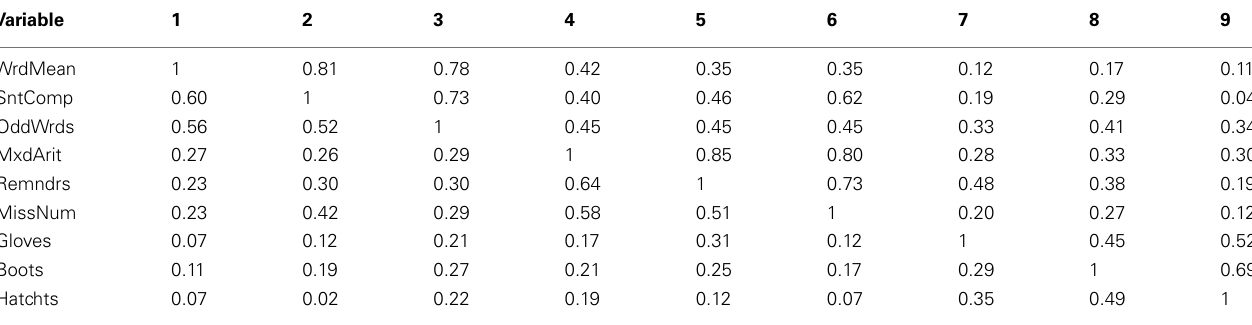
Table 5 | Product-moment and polychoric correlations among Case 1 item-level